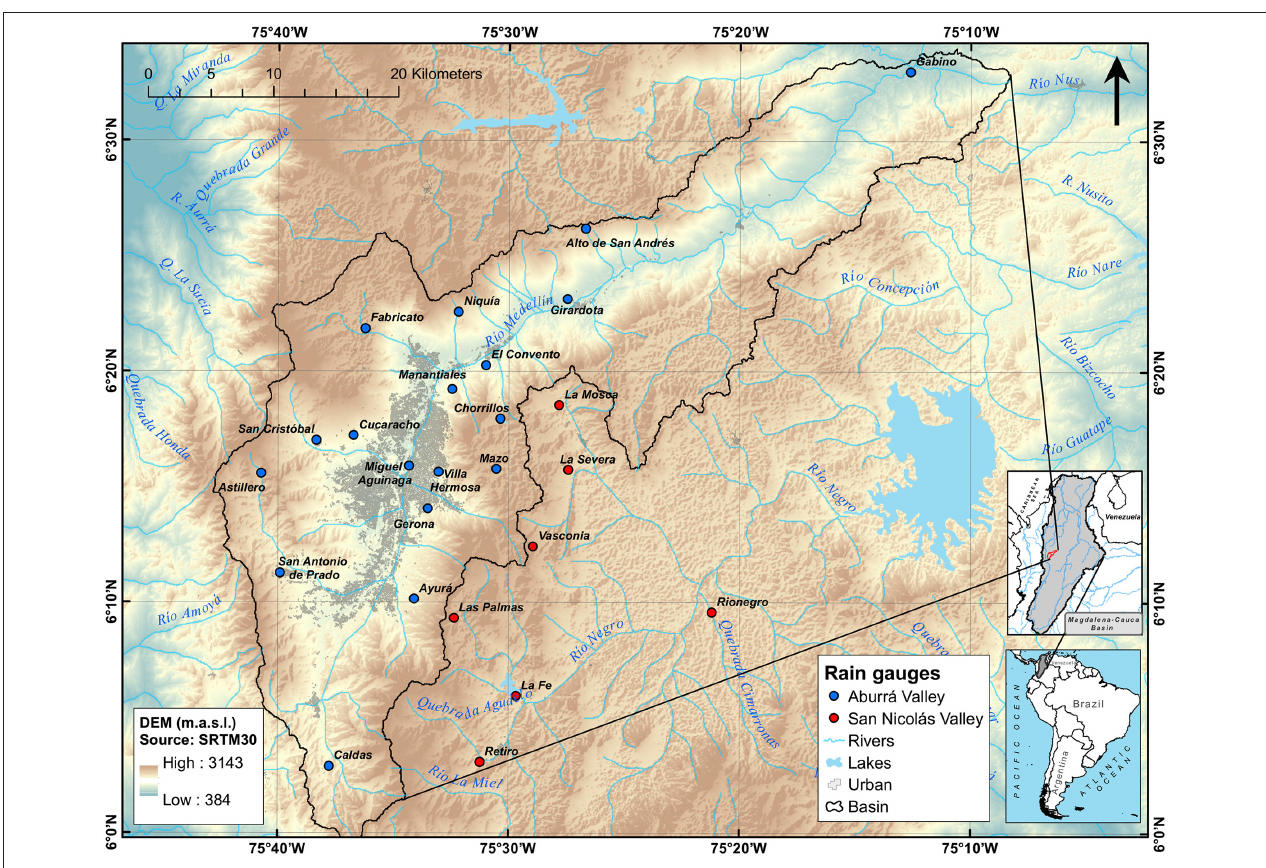
FIGURE 1 | Location of the region and rain gauges included in the study. The middle inset depicts the location of the Magdalena-Cauca River